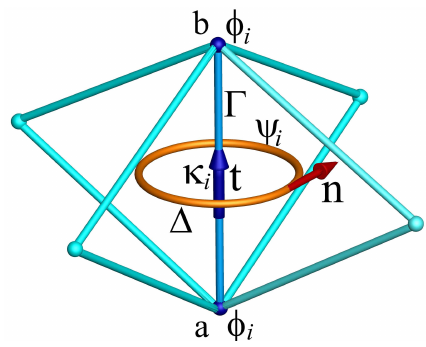
Figure 12. Scheme of the inertia vector κ i on the oriented segment Γ and the respective representations of its two components such that κ i = ∇ φ i − ∇ d × ψ i